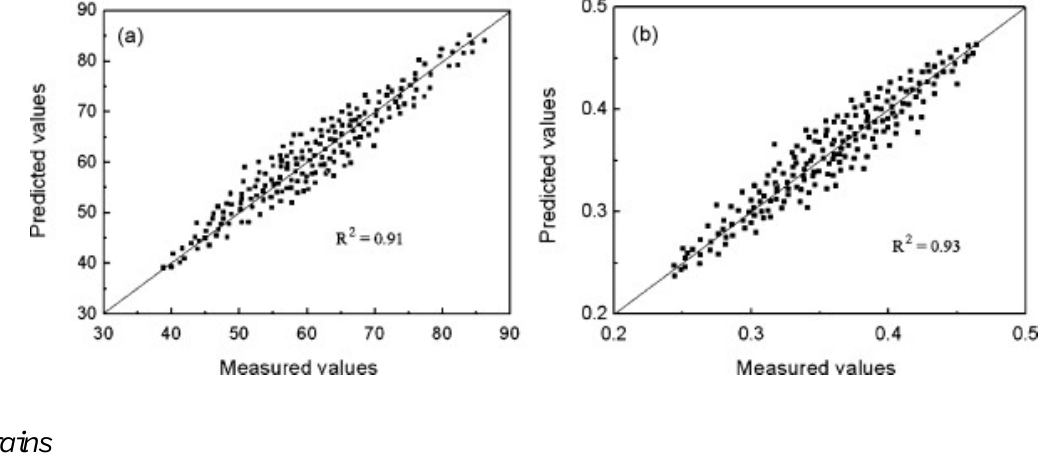
Figure 3. Predicted versus E-nose-measured values of egg quality indices from quadratic polynomial step regression models (a) Haugh unit and (b) yolk factor (reprinted from [46] with permission from Elsevier, copyright